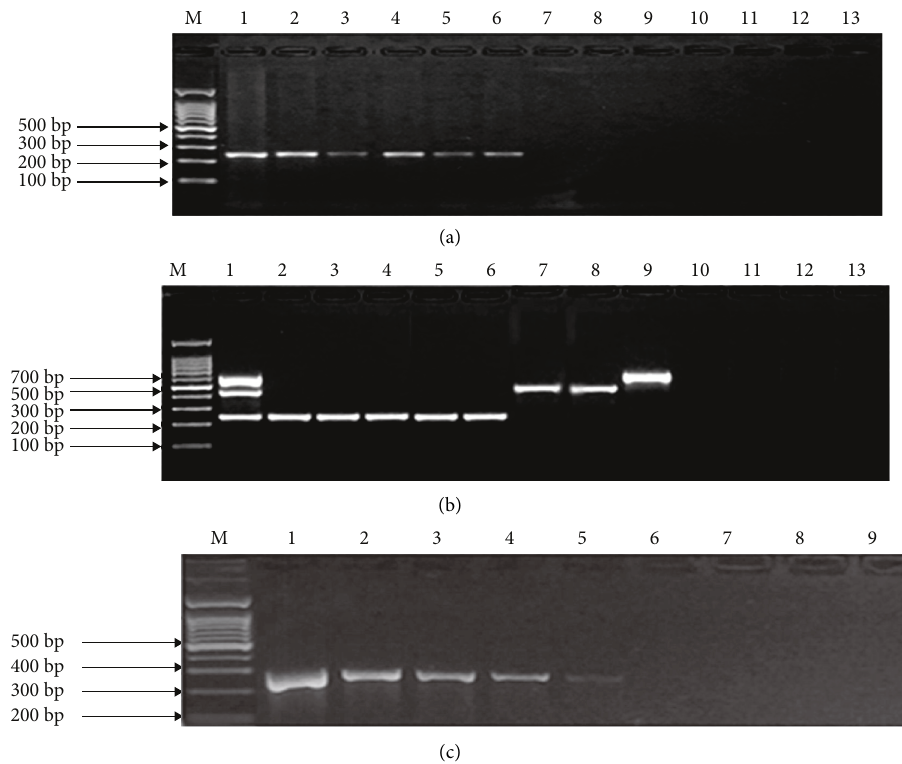
Figure 3: Specificity and sensitivity tests of the PCR assay using gel electrophoresis. (a) Specificity tests of the simplex-PCR assay using gel electrophoresis. M: Marker; 1: a mixture of DNA extracted from three species; 2 ∼ 4: bovine bone marrow listed as 2016BH001, 2016BH002, and 2016BH003; 5 ∼ 6: commercially available BBM; 7 ∼ 8: donkey bone marrow; 9: pig bone marrow; 10: sheep bone marrow; 11: deer bone marrow; 12: horse bone marrow; 13: negative control. (b) Specificity tests of the multiplex PCR assay using gel electrophoresis. M: Marker; 1: a mixture of DNA extracted from three species; 2 ∼ 4: bovine bone marrow listed as 2016BH001, 2016BH002, and 2016BH003; 5 ∼ 6: commercially available BBM; 7 ∼ 8: donkey bone marrow; 9: pig bone marrow; 10: sheep bone marrow; 11: deer bone marrow; 12: horse bone marrow; 13: negative control. (c) Sensitivity tests of the PCR assay using gel electrophoresis. M: Marker; 1: DNA extracts of BBM samples diluted to100ng/ μ L; 2:10 ng/ μ L; 3: 1ng/ μ L; 4 :100 ° pg/ μ L; 5:10 ° pg/ μ L; 6 :1 ° pg/ μ L; 7: 0.1 ° pg/ μ L; 8:0.01 ° pg/ μ L; and 9: negative control.